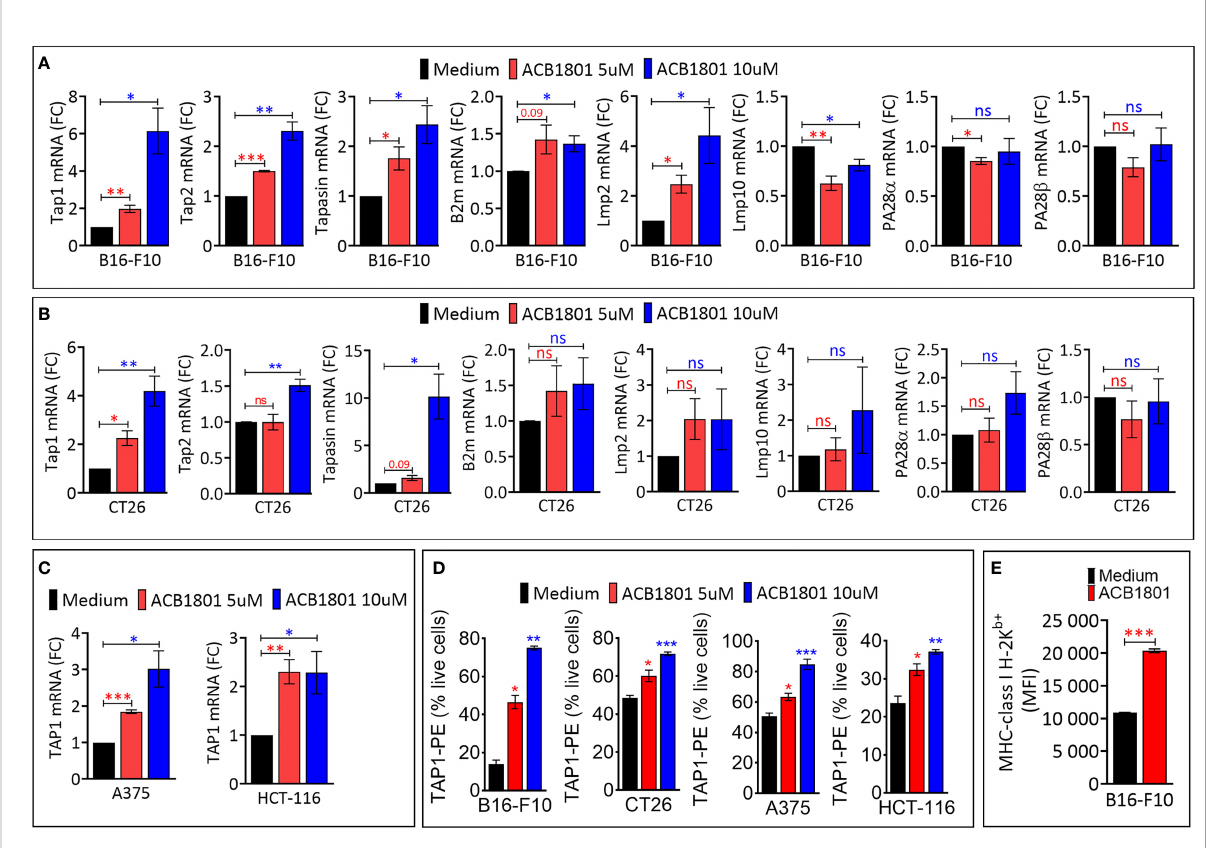
FIGURE 1 ACB1801 upregulates the expression of TAP1 in various murine and human tumor cells (A, B) . The mRNA expression of Tap1, Tap2, Tapasin, B2m, Lmp2, Lmp10, PA28 a , PA28 b , in mouse melanoma B16-F10 (A) and colorectal CT26 (B) cancer cells. (C) The mRNA expression of TAP1 in human melanoma A375 and colorectal HCT-116 cells. B16-F10, A375, CT26, and HCT-116 cells were treated for 24 h with culture medium (control) or with two concentrations of ACB1801 (5 and 10 uM). Results are reported as fold change (FC) relative to control cells treated with medium (black bars). (D) Flow cytometry analysis of the expression of TAP1 protein in B16-F10, CT26, A375, and HCT-116 cells treated for 24 h with culture medium (control) or two concentrations of ACB1801 (5 and 10 uM). Results are reported as % of positive cells relative to live cells. (E) Flow cytometry analysis of the expression of MHC-class I H-2K b allotype on the cell surface of B16-F10 cells treated for 24 h with culture medium (control) or ACB1801 (5 uM). Results in (A – E) represent the averages of three independent experiments and are shown as mean ± SEM (error bars). Statistically signi fi cant differences were calculated relative to control conditions using an unpaired two-tailed student ’ s t-test (ns, not signi fi cant, * =p< 0.05, ** =p< 0.005, and